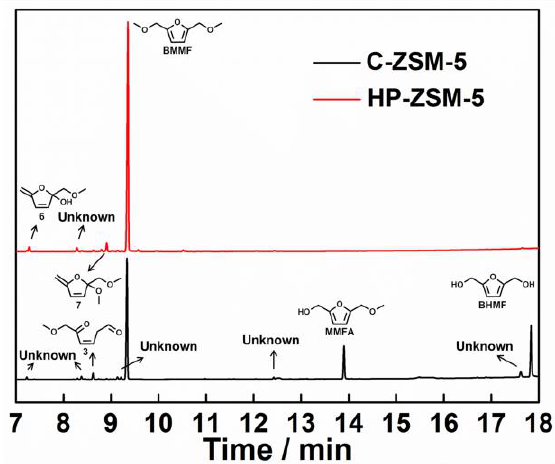
Figure 3. Gas Chromatography (GC) spectrum of the by-products on the C-ZSM-5 and HP-ZSM-5.